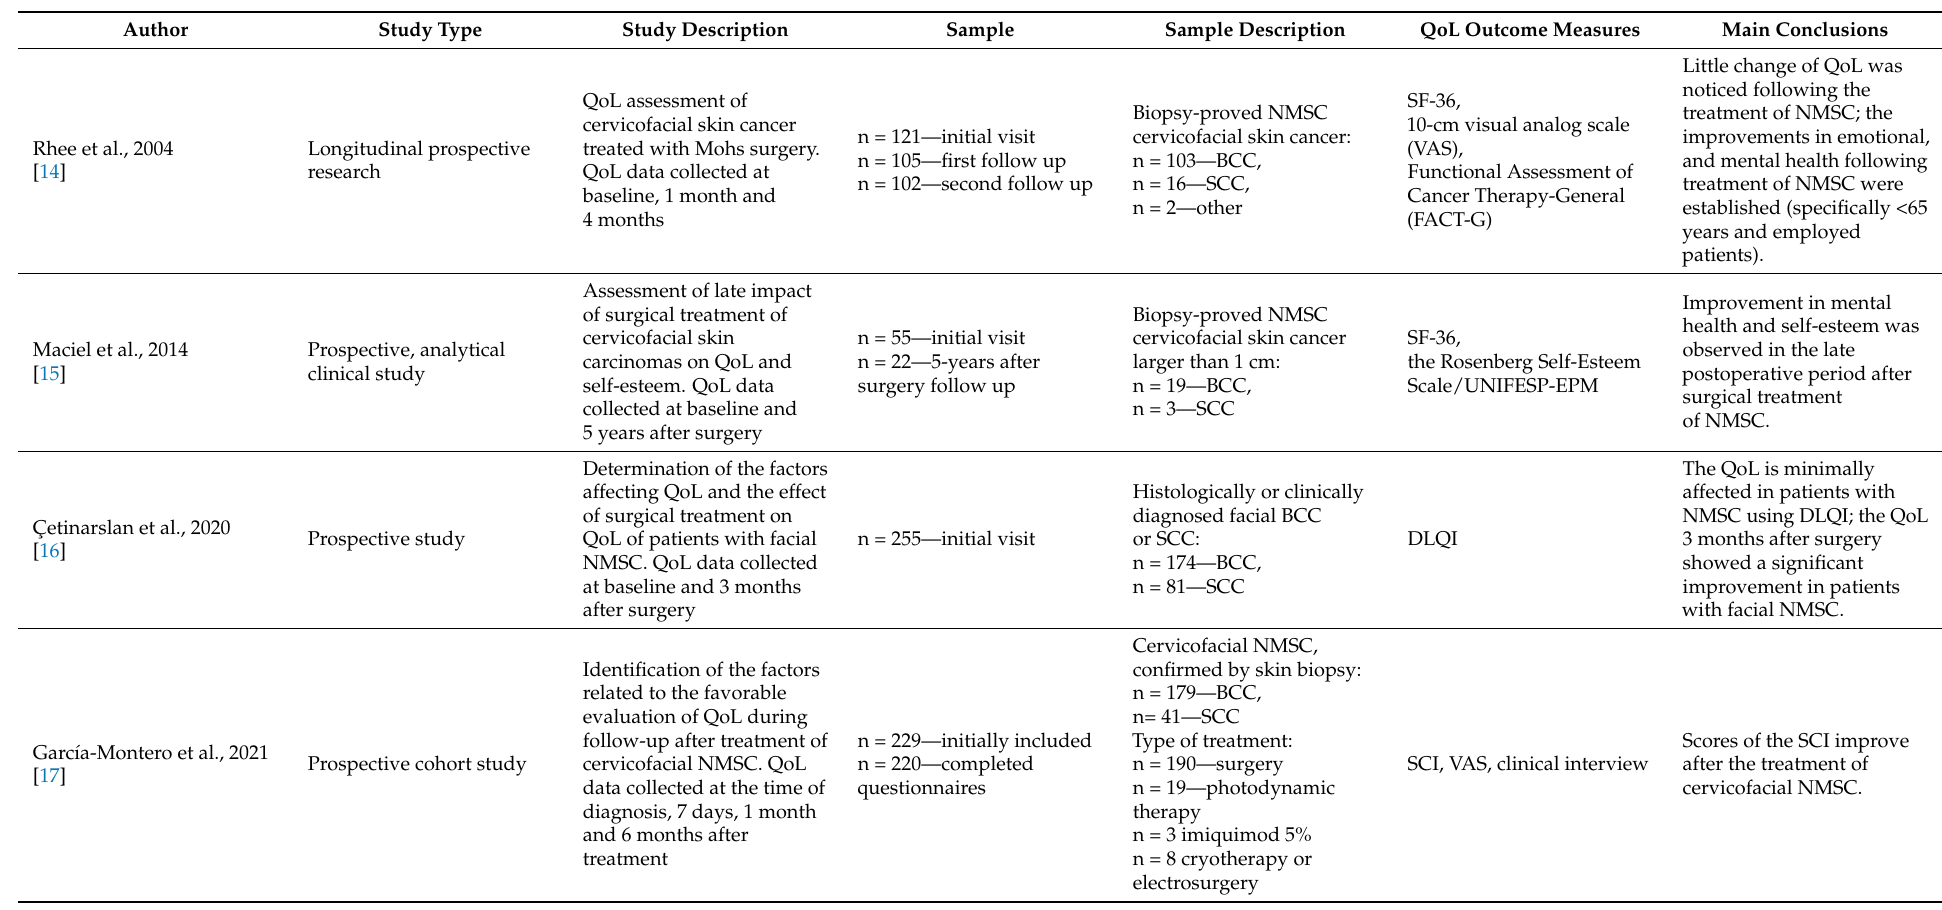
Table 1. Detailed summary of the selected